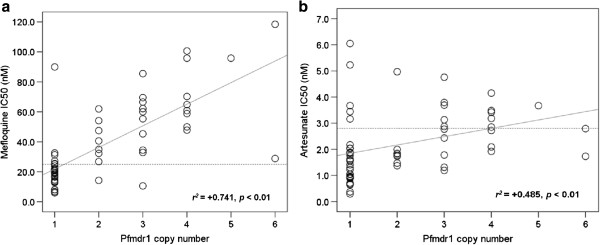
Correlation between pfmdr1 copy number and in vitro sensitivity of Plasmodium falciparum isolates to (a) mefloquine, and (b) artesunate. (Dashed lines represent the cut-off IC50 values for resistance to mefloquine/reduced sensitivity to artesunate).